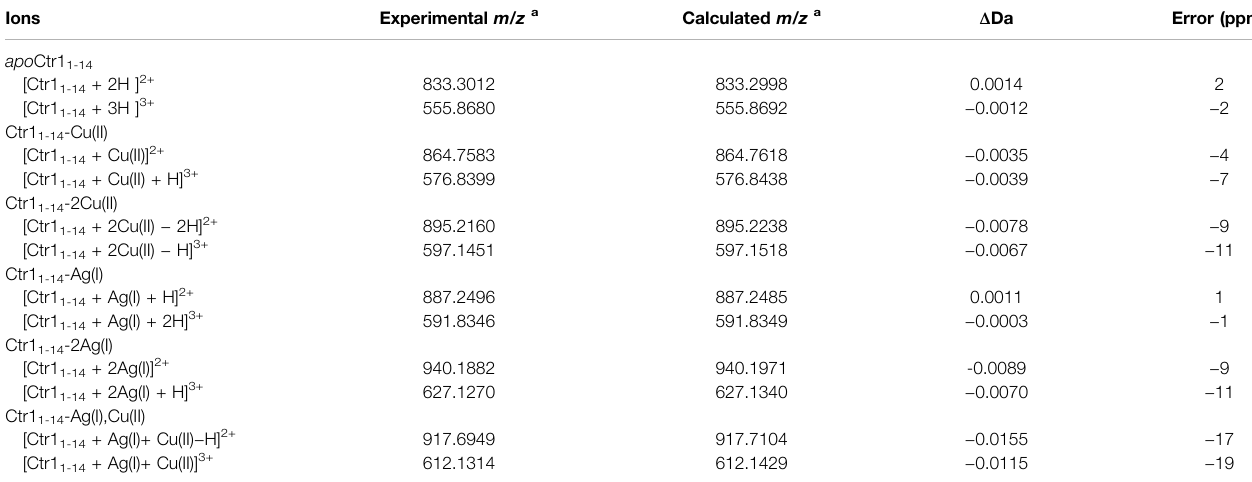
TABLE 1 | Stoichiometry of Ctr1 1-14 complexes with Cu(II) and Ag(I) ions observed by ESI-MS.